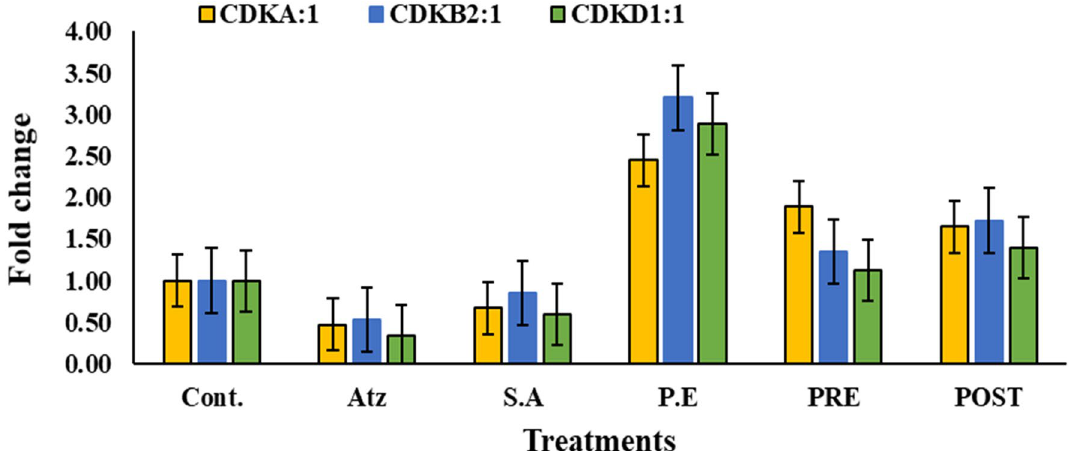
Figure 3. Effects of treatments with atrazine (ATZ), sodium azide (S.A), plant extract (P.E), Pre-treatment (PRE) and Post-treatment (POST) on CDKA:1, CDKB:2, CDKD1:1 fold change expression level in the root tip cells of Allium cepa . All values are relative to average expression level, of the root tips cells of Allium cepa treated with the tap water, atrazine, sodium azide, PE, PRE and POST treatment in triplicate, n = 3 and mean ±